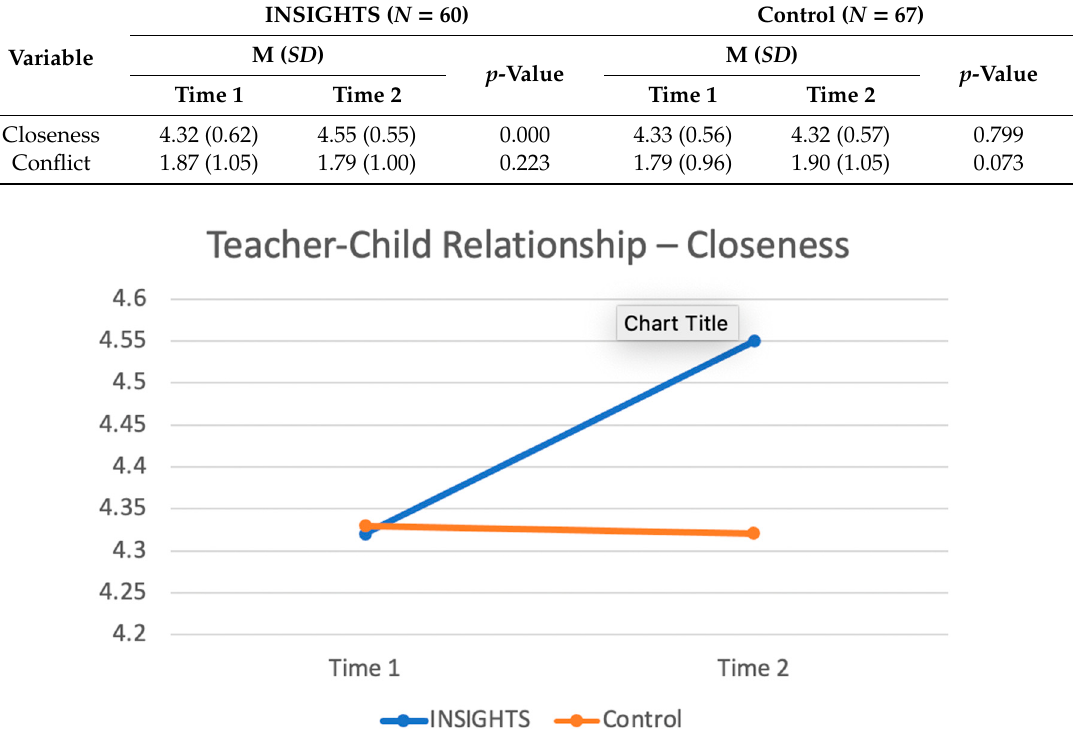
Figure 1. Pre- and post-INSIGHTS intervention of INSIGHTS and control groups.